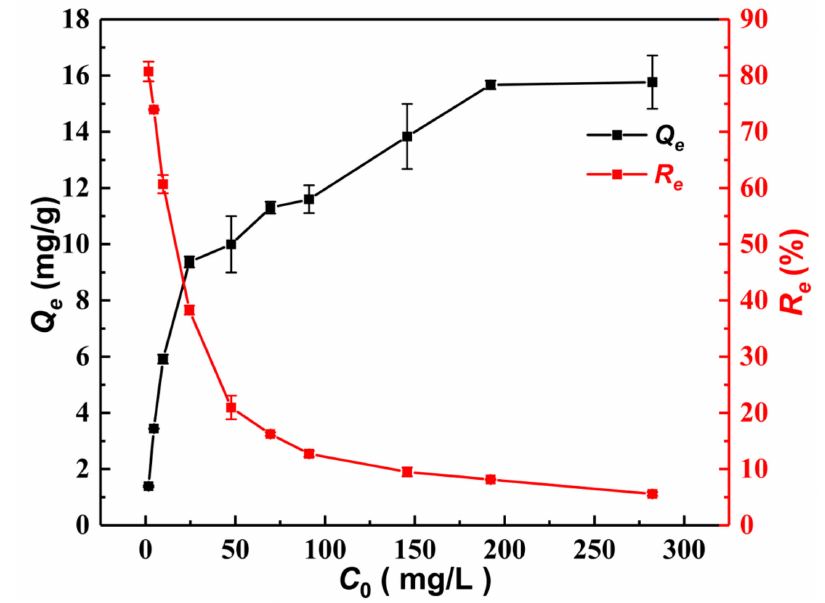
Figure 10. Changes in As(III) adsorption capacities ( Q e ) and removal efficiency ( R e ) with the initial concentration of